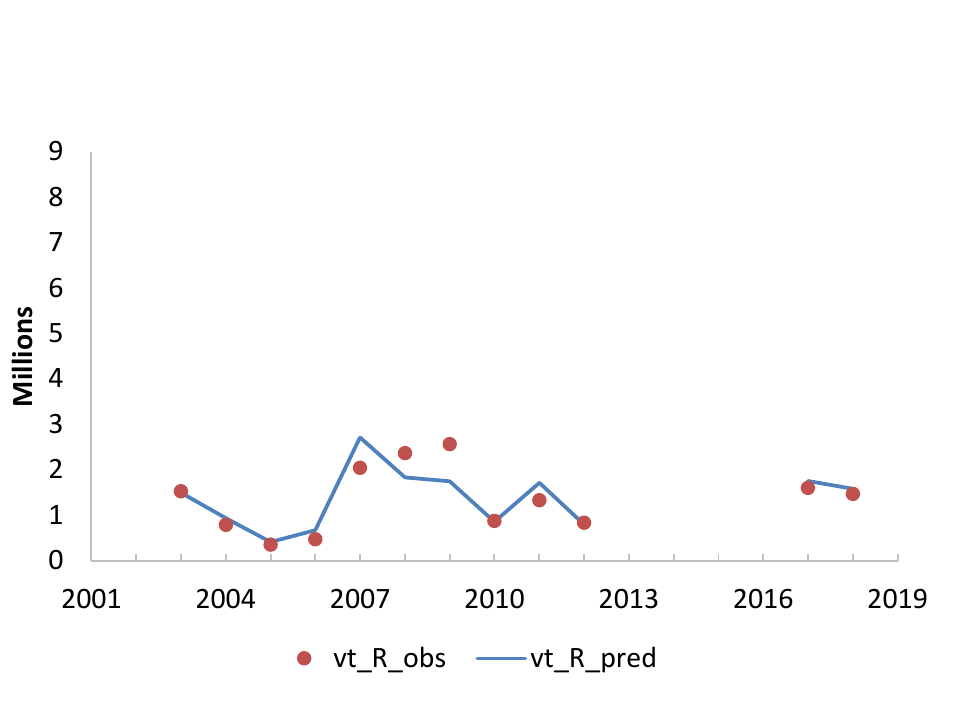
Figure 102. CMSA model fit to the primiparous female index from the Virginia Tech Trawl Survey.